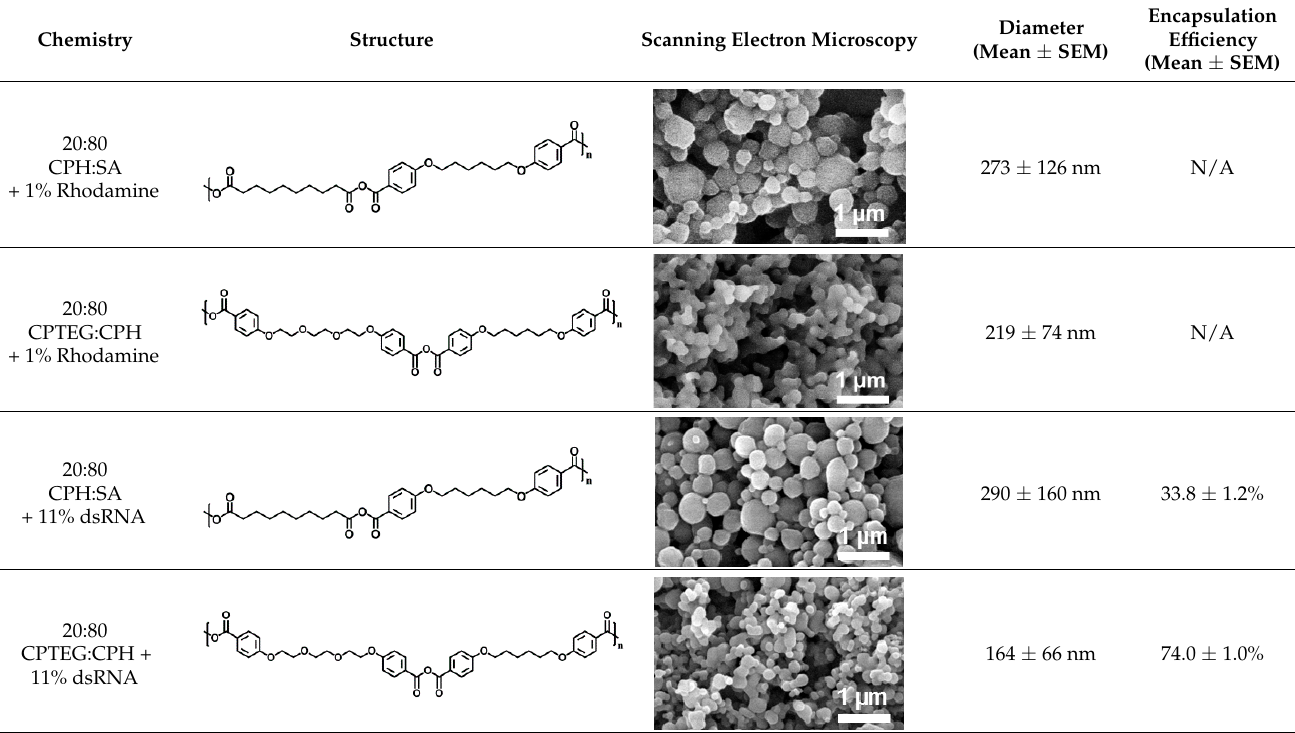
(Table 1). Nanoparticles loaded with 11% dsRNA had a mean diameter of 290 ± 160 nm and 164 ± 66 nm for 20:80 CPH:SA and 20:80 CPTEG:CPH, respectively (Table 1) consistent with previous work [16,22]. The Table 1. Polyanhydride Nanoparticle Characterization.